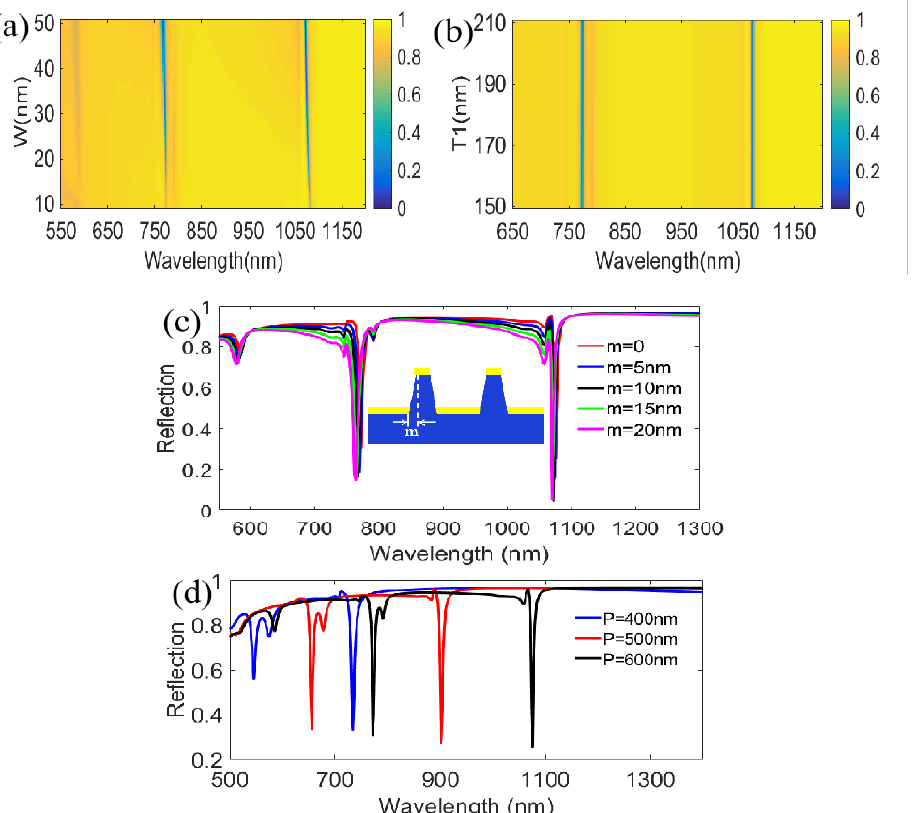
Figure 14. Influences of different parameters on the reflection spectra for TM polarized incidence at θ = 10° from the structural bottom. ( a ) Change of the grating width; ( b ) Change of the grating height; ( c ) Change of grating ridge shape; ( d ) Change of the grating period.